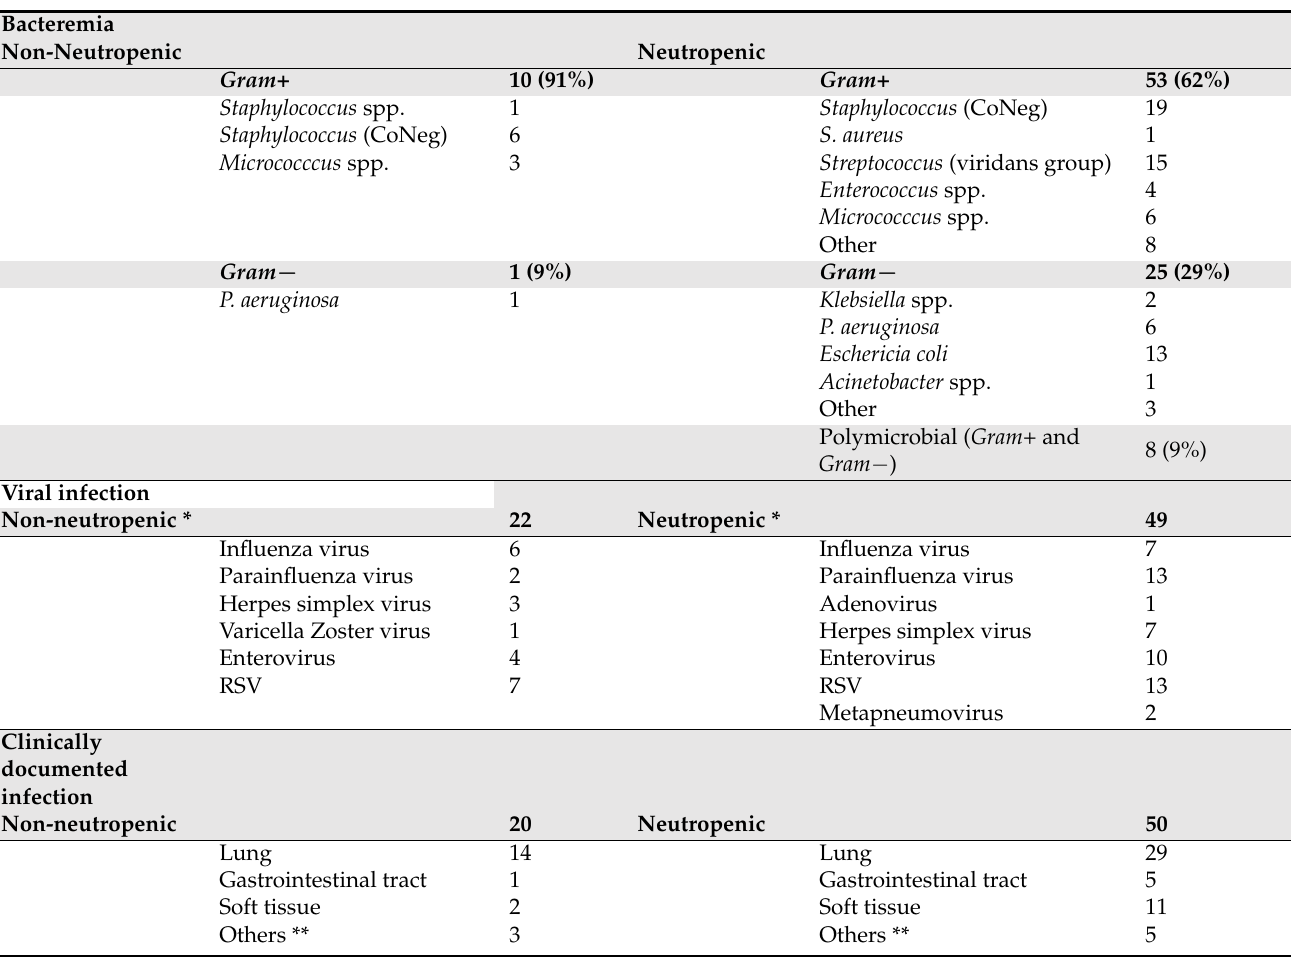
Table 2. Bacteremia, viral infections and clinically documented infections in neutropenic and non- neutropenic cancer